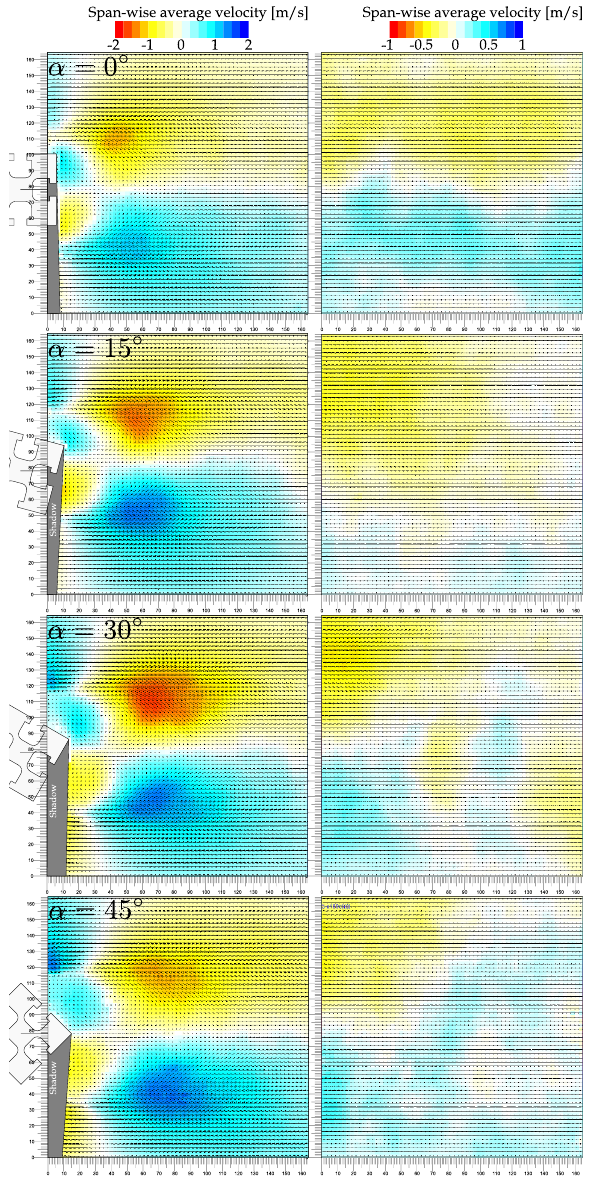
Fig. 2. Spatial distribution of the of the averaged span-wise velocity. Stream-wise velocity is 5 . 0m / s, corresponding Re = 1 . 5 · 10 4 . The angle of attack α is from top 0 ◦ , 15 ◦ , 30 ◦ and 45 ◦ respectively. Note that the legend limits are di ff erent in left and right column.